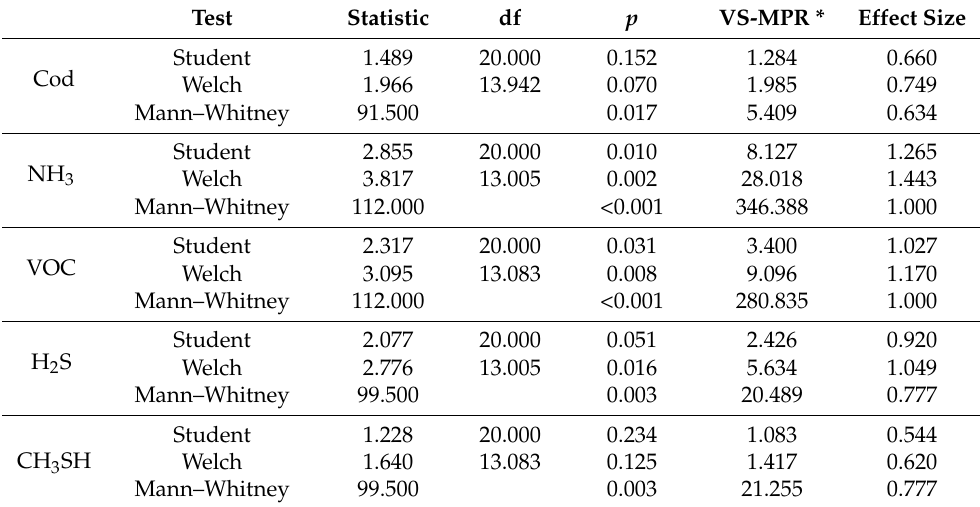
Table 2. Results of independent sample T -test for air compounds determinations.